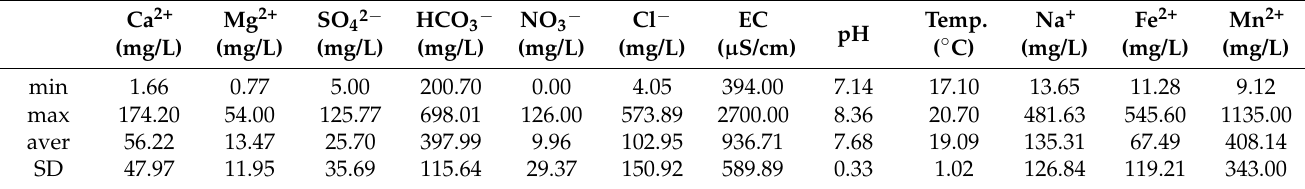
Table 4. Statistical analysis of some of the major chemical constituents from groundwater samples (October 2019) (confined aquifer).